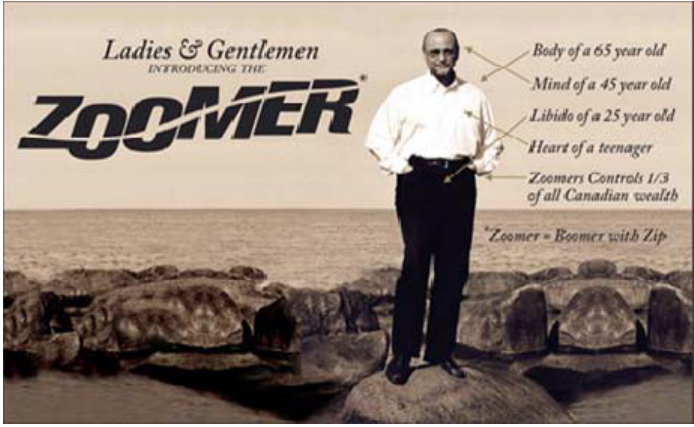
Online Advertisment for the 2011 Zoomer Show, Zoomer